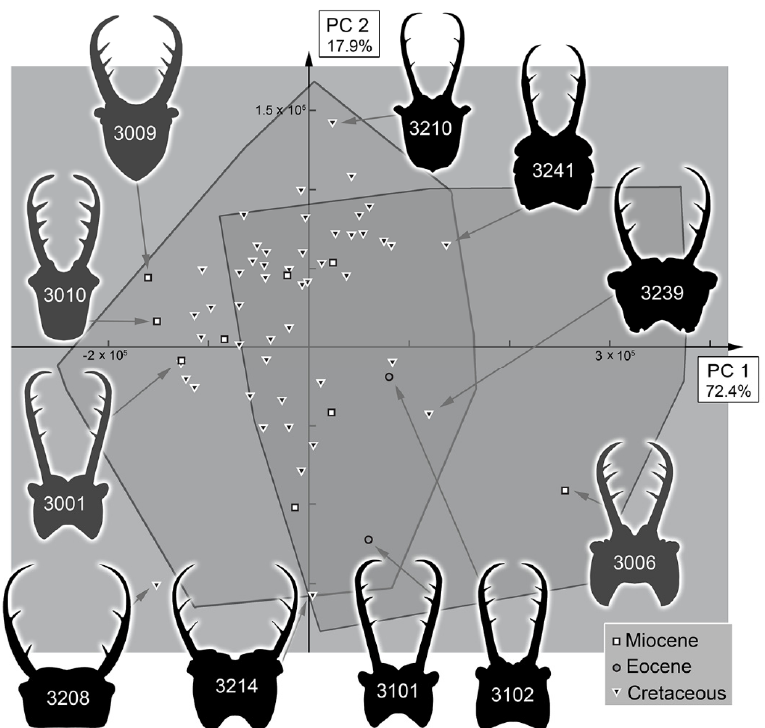
Figure 38. Scatterplot of PC2 vs. PC1 values of head shapes of fossil specimens. Extant specimens only shown as occupied area to highlight position of fossil specimens. Black heads = Cretaceous and Eocene larvae; grey heads = Miocene larvae.